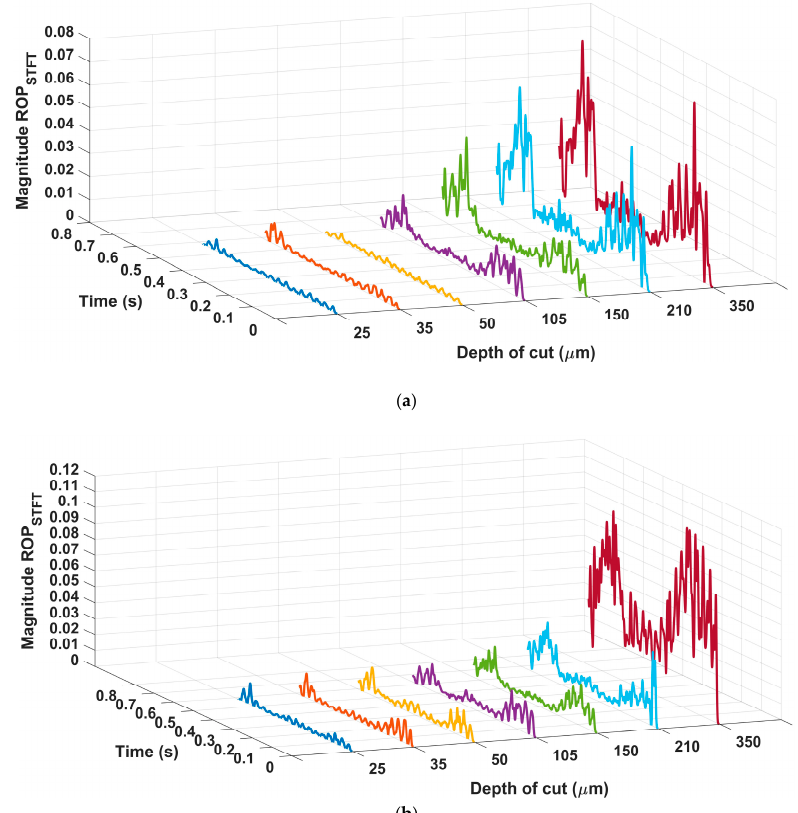
Figure 5. The ratio of power (ROP) of the ( a ) acoustic emission sensor (AE) and ( b ) piezoelectric diaphragm (PZT). diaphragm